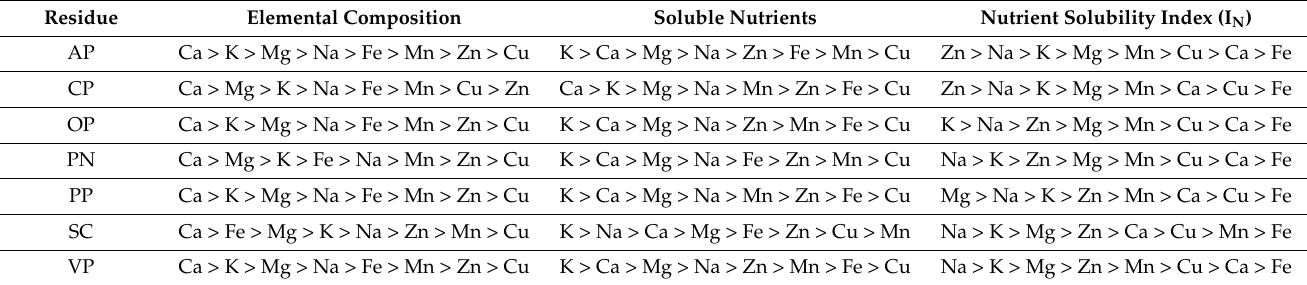
Table 8. Nutrients ordered from higher to lower concentration in elemental composition, aqueous extract and solubility